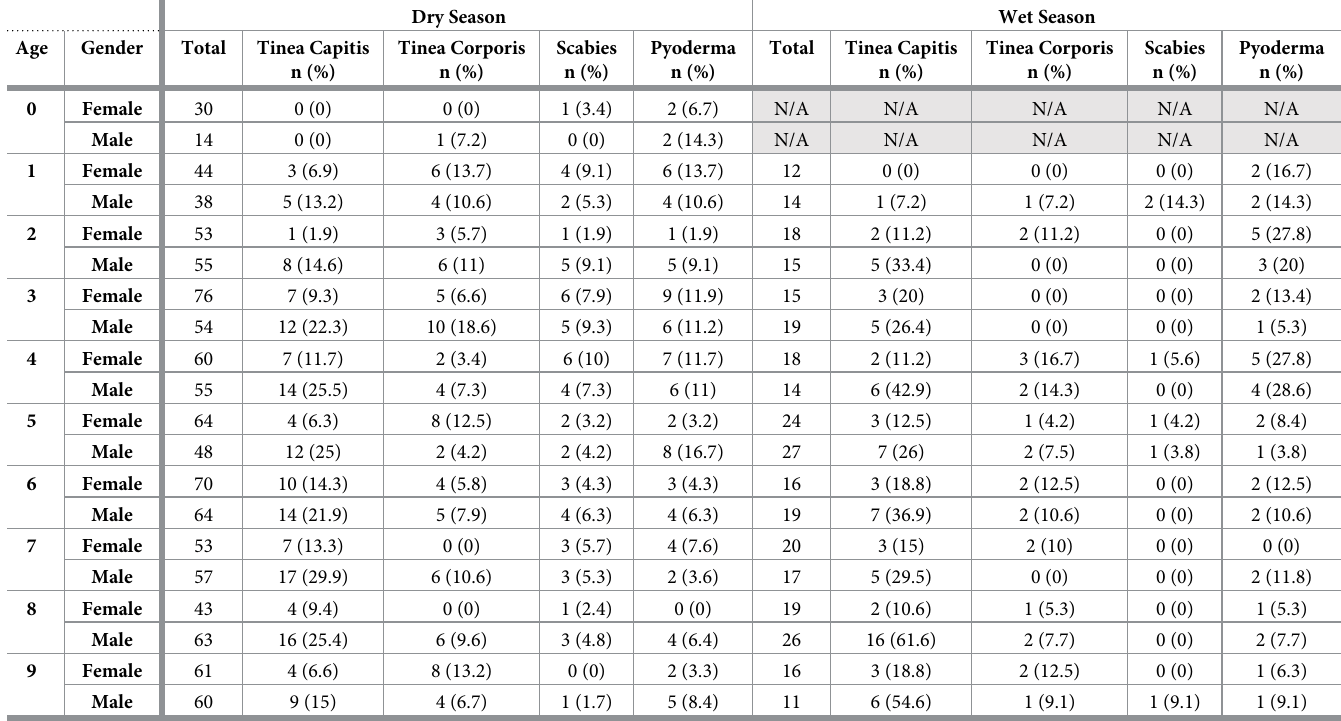
Table 3. Prevalence of each skin infection by age, gender and